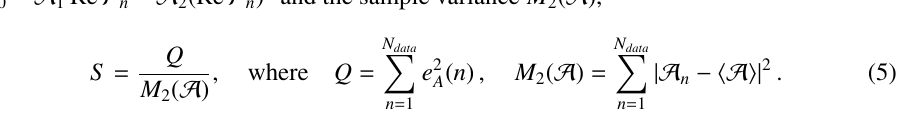
is the sample average. Left panel: A 0 hAi > P